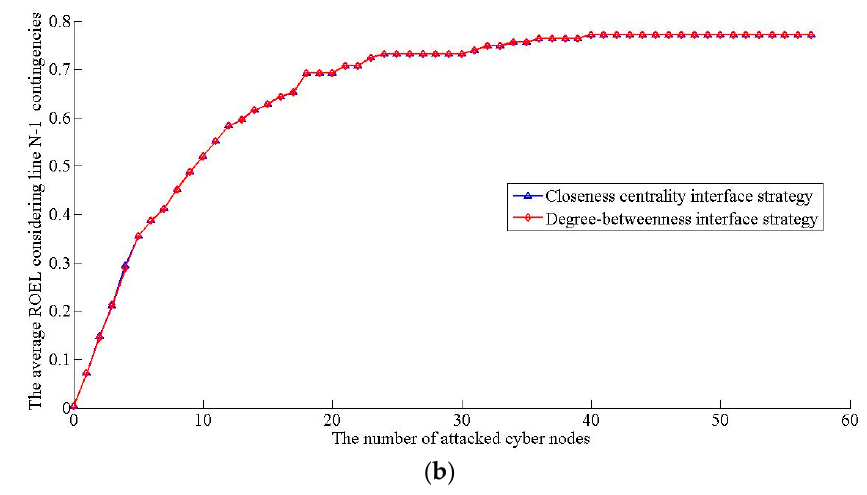
Figure 5. Using different cyber-physical interface strategies, the average vulnerability indices of CPPS considering line N − 1 contingencies: ( a ) ROLL; ( b ) ROEL.